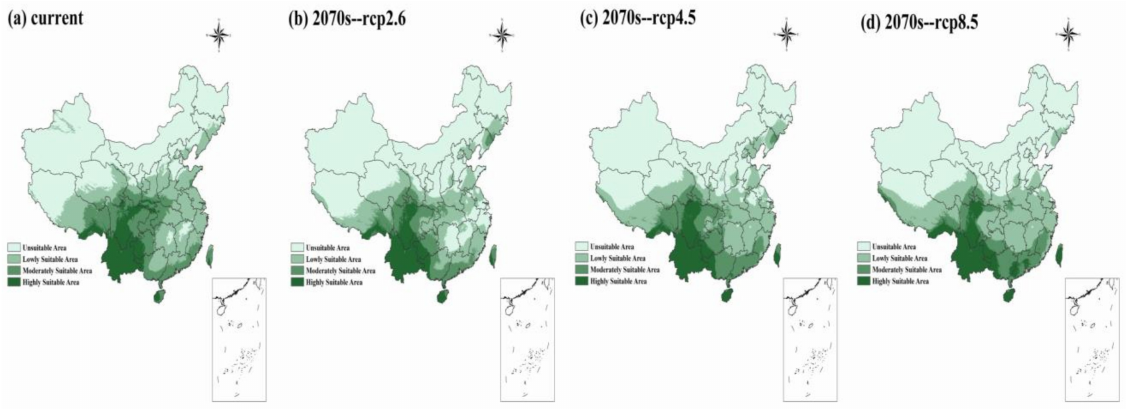
Figure 2. The potentially suitable areas of wild buckwheat species in the current day and in the